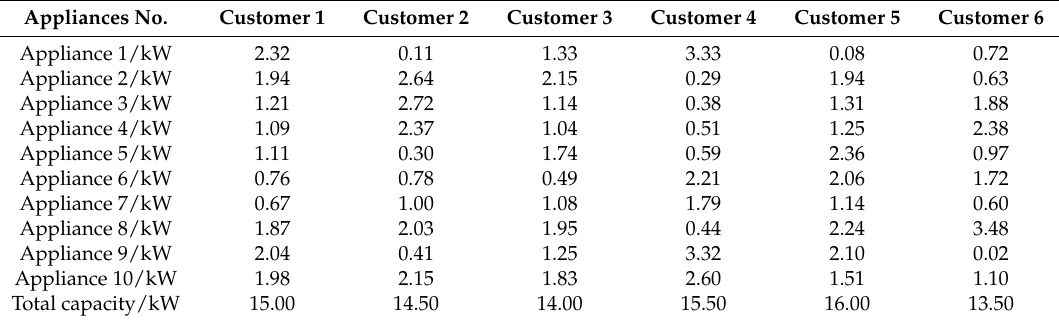
Table 1. The power capacity parameters of home appliances of six customers.